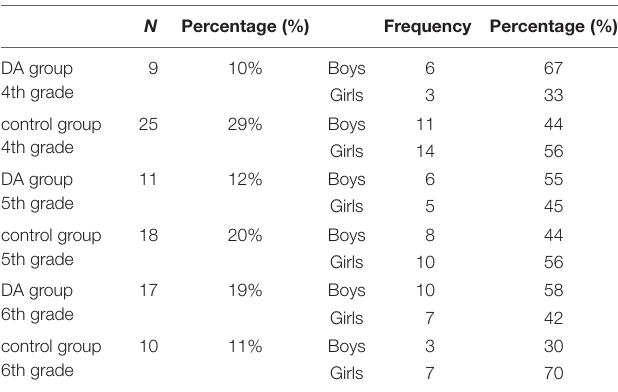
TABLE 1 | Sample distribution by group, grade and